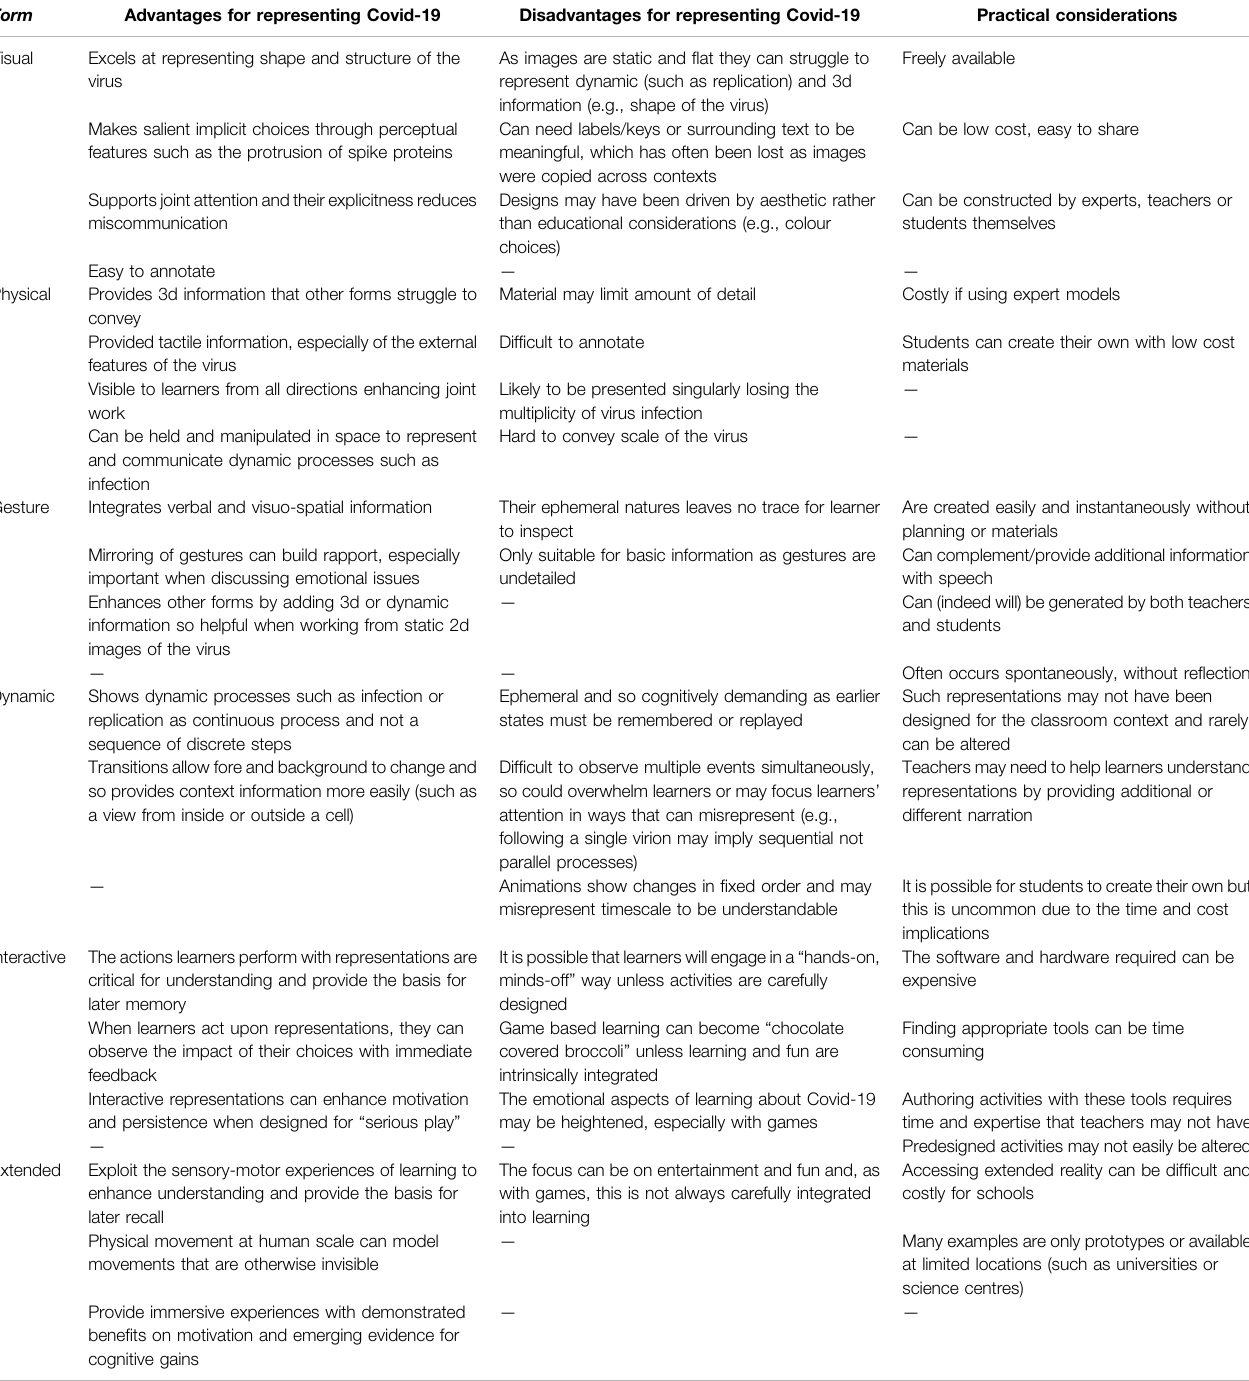
TABLE 1 | Advantages and disadvantages of different ways of representing Covid-19. Form Advantages for representing Covid-19 Disadvantages for representing Covid-19